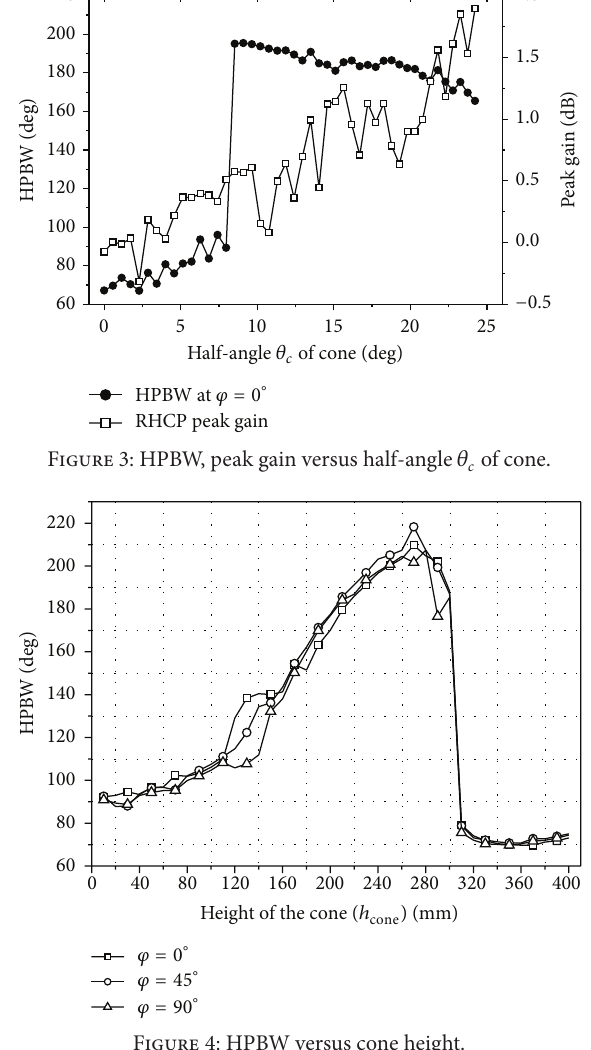
Figure 4: HPBW versus cone height.